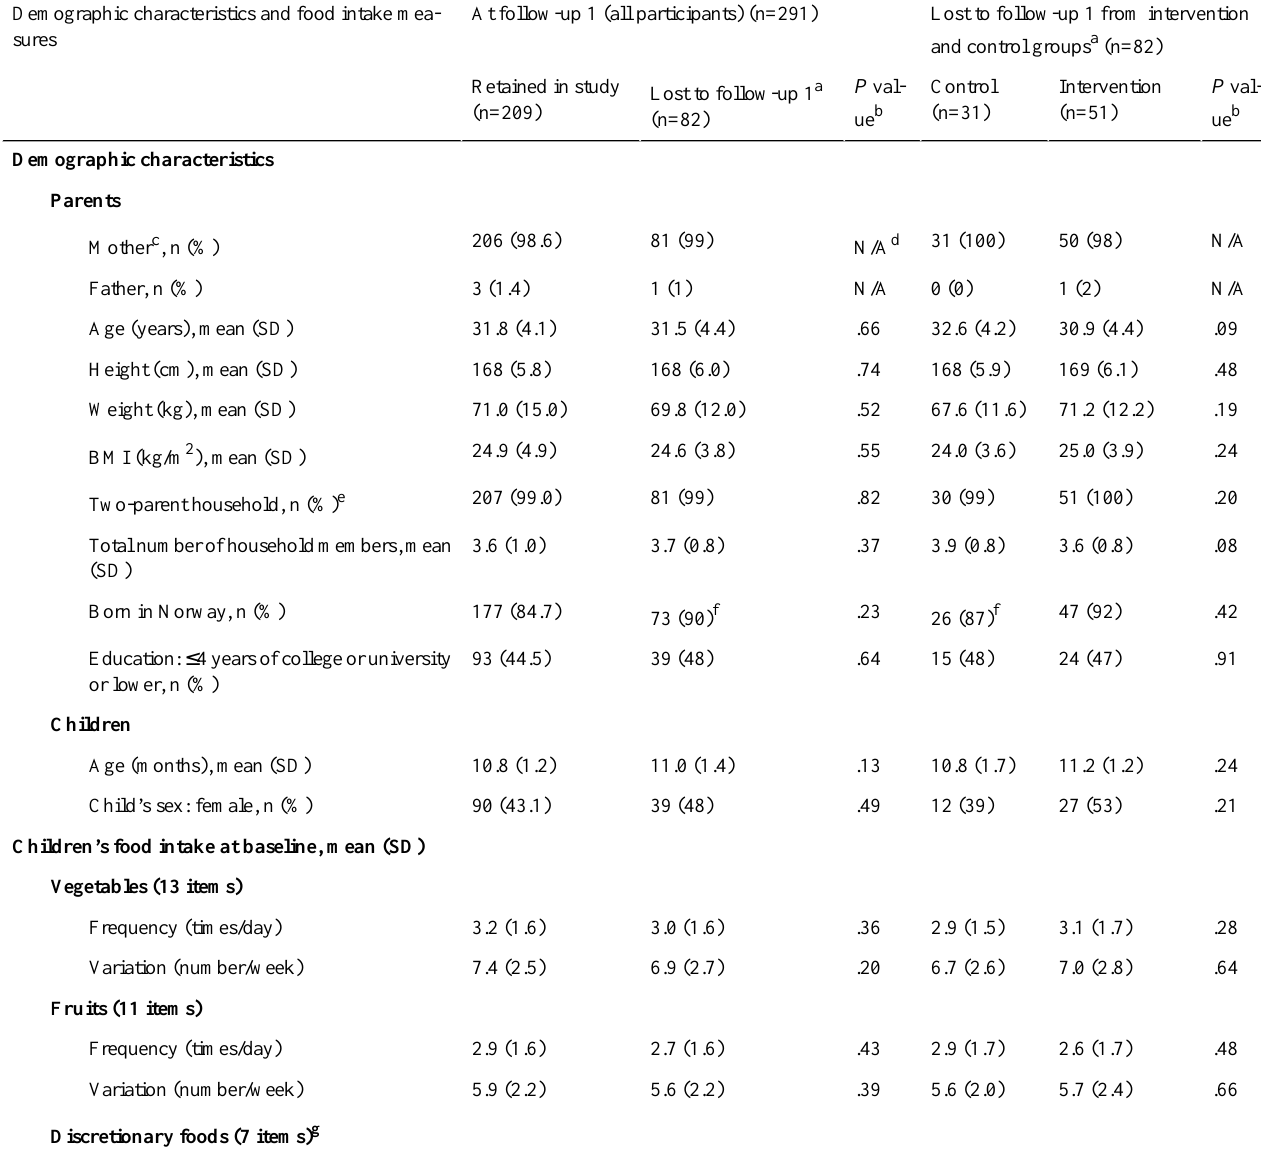
Table 2. Differences in baseline characteristics and food intake between participants who remained in the study and those lost to follow-up 1.